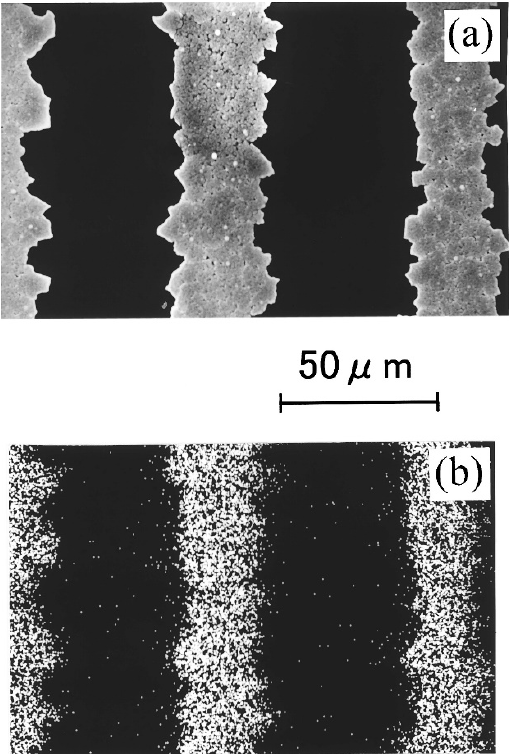
Figure 4. ( a ) SEM image of nominal 25- μ m TiO 2 lines from liquid phase deposition, and ( b ) the corresponding EDX Ti X-ray map image confirming the selective deposition of TiO 2 on the patterned surface. Reprinted with permission from [88], © 1999, American Chemical Society.